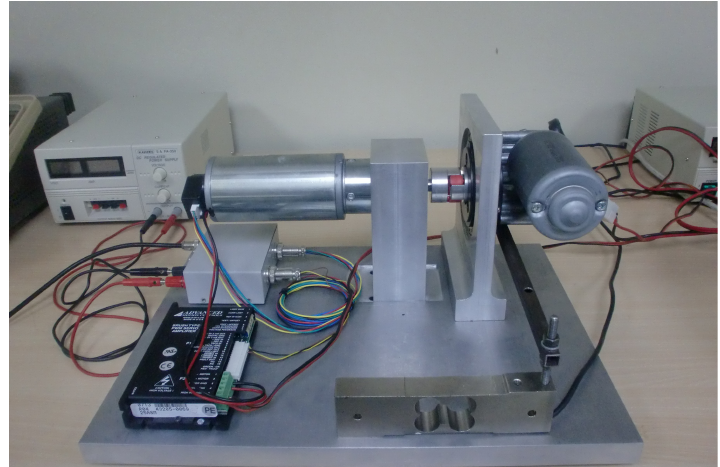
Figure 3. Experimental setup used in the actvity